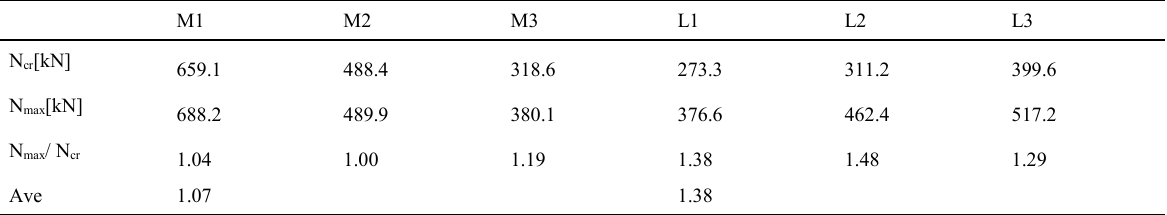
Table 3: Cracking load and failure